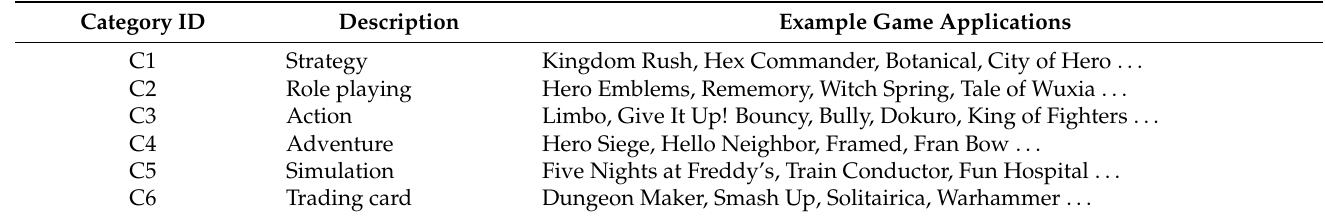
Table 1. Typical collected mobile games in 6 market categories.